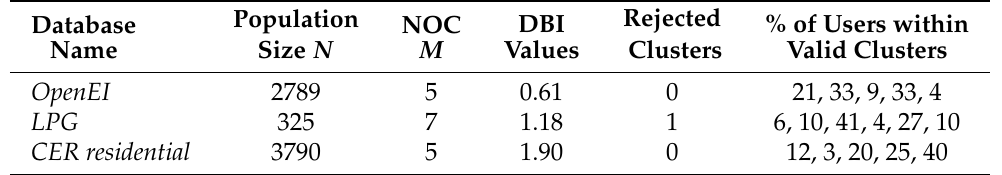
Table 1. Clustering results obtained with the AHC algorithm applied to the three data set under study, i.e., OpenEI , LPG , CER residential